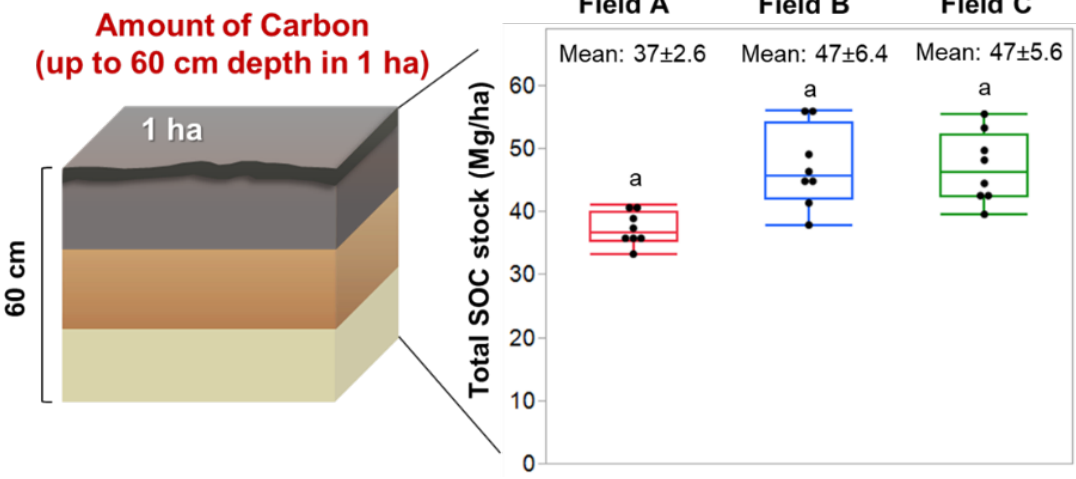
Figure 5. Median, mean (point), 25 th , and 75 th percentile of soil organic carbon stocks at 0–60 cm depth in eight sampled grids for each field. Similar letters indicate no significant ( p < 0.05) differences in SOC stocks among three fields.